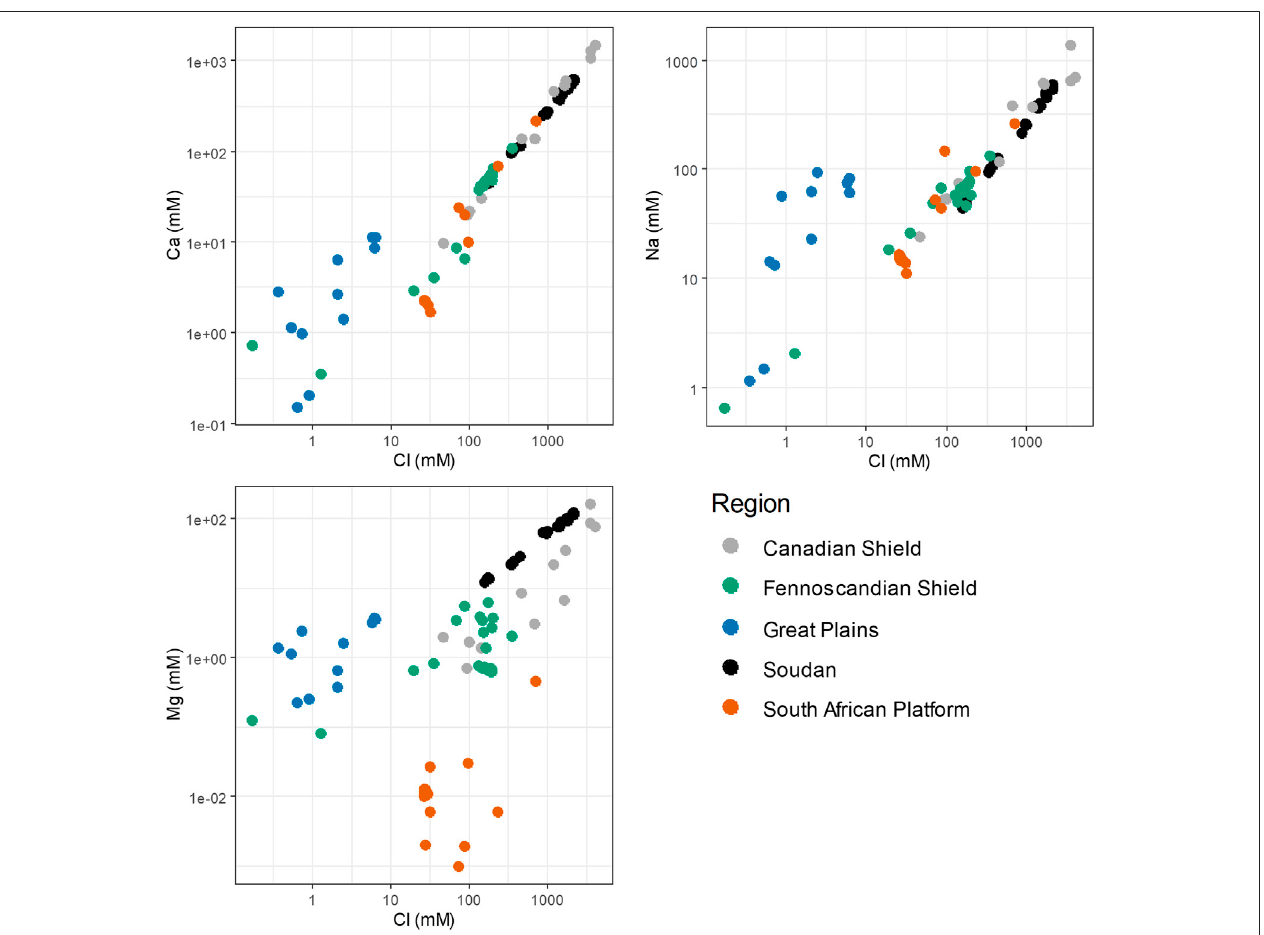
FIGURE 8 | Variation in major ion concentrations among deep biosphere research sites in different regions. Canadian Shield data were published in (Onstott et al., 2009), (Telling et al., 2018), and (Lollar et al., 2019). Fennoscandian Shield data were published in (Pedersen, 1997), (Itävaara et al., 2011), and (Wu et al., 2016). Great Plains data were published in (Osburn et al., 2014). South African Platform data were published in (Baker et al., 2003), (Moser et al., 2003), (Kieft et al., 2005), and (Lin et al., 2006).